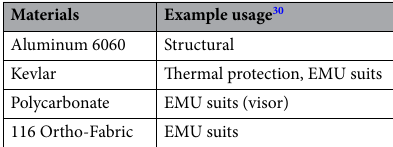
Table 1. Materials selected to be